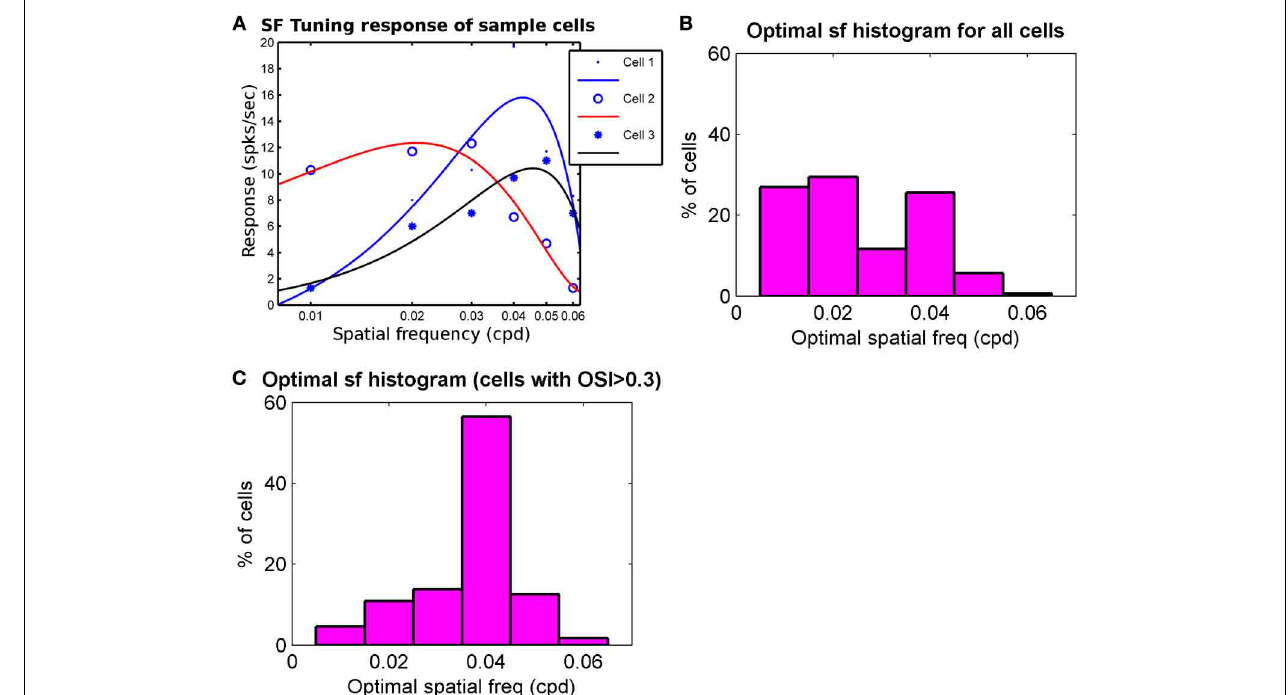
FIGURE 5 | (A) The spatial frequency response of 3 sample cells. The response at sample frequencies (0.01–0.06 cycles/ ◦ with intervals of 0.01 cycles/ ◦ ) and velocity of 100 ◦ /s is fitted with cubic spline to determine optimal spatial frequency. Optimal spatial frequency for Cell 1–Cell 3 are 0.042 cycles/ ◦ , 0.022 cycles/ ◦ , and 0.048 cycles/ ◦ , respectively. (B) The